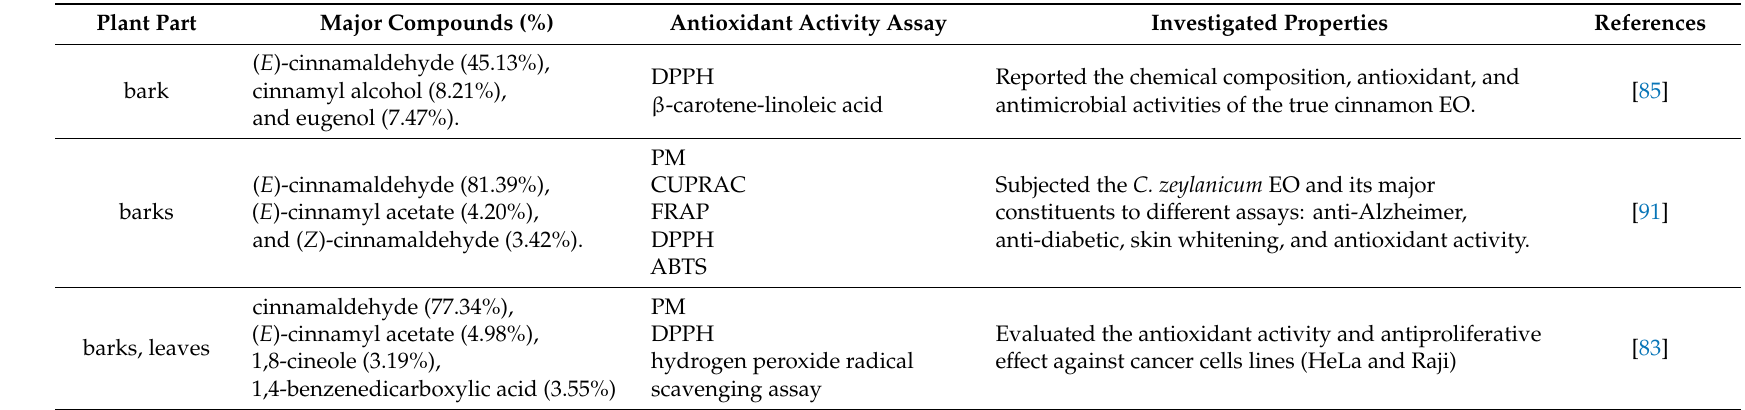
Table 1. Major natural compounds, methodologies applied to determine the antioxidant activity, and the investigated applications of Cinnamomum zeylanicum (Lauraceae) essential oils